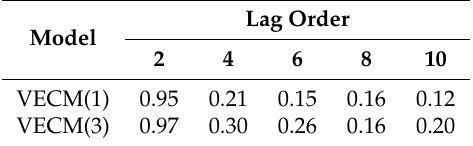
Table 4. p -values of Ljung–Box autocorrelation test for VECM.